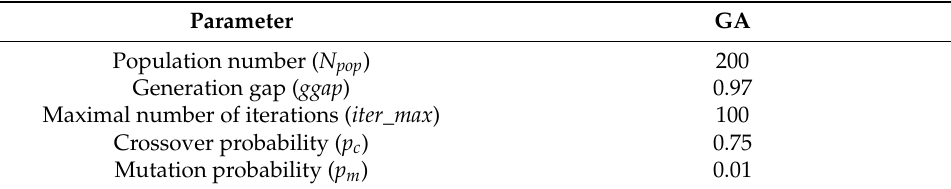
Table 3. GA parameters.